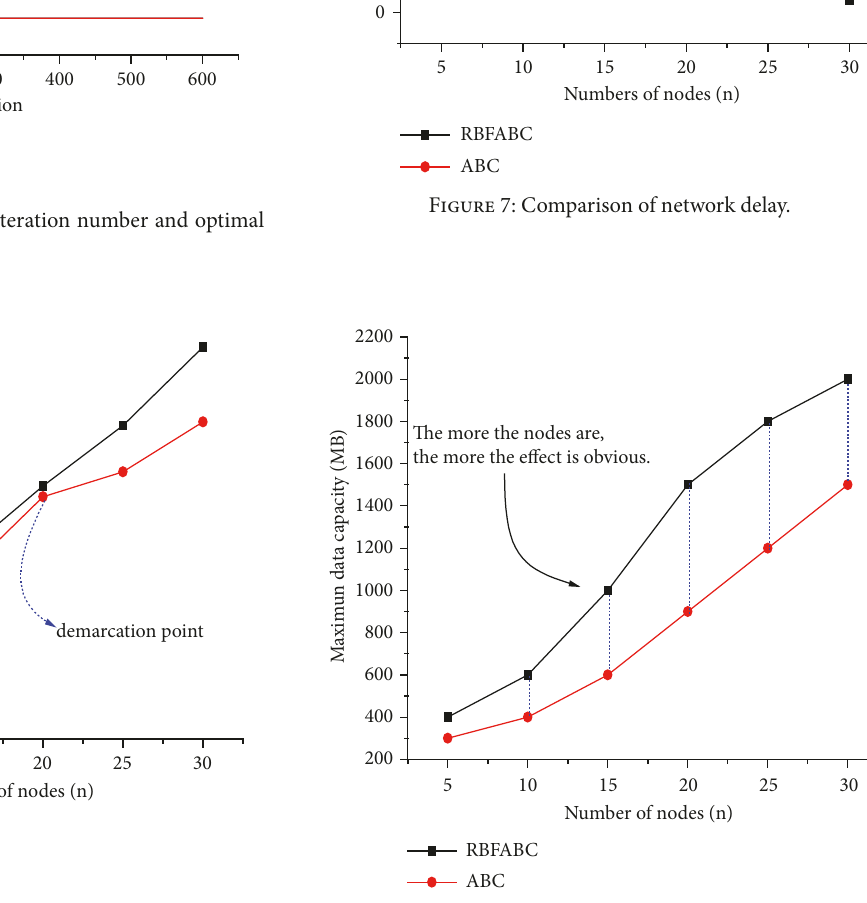
Figure 8: Maximum load